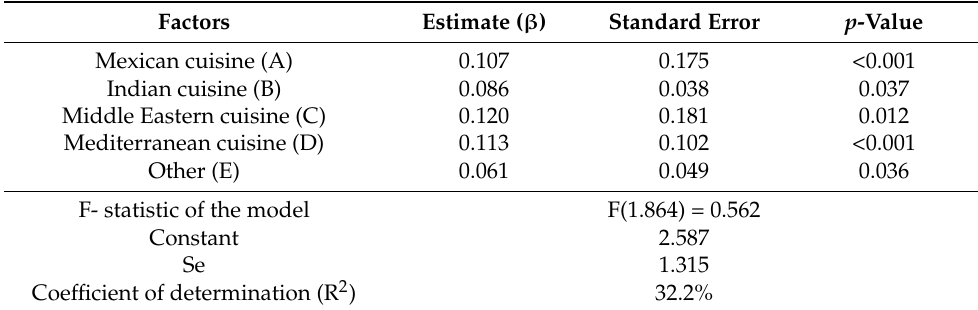
Table 7. The relationship between the culinary trend and the tendency to buy and consume pulse